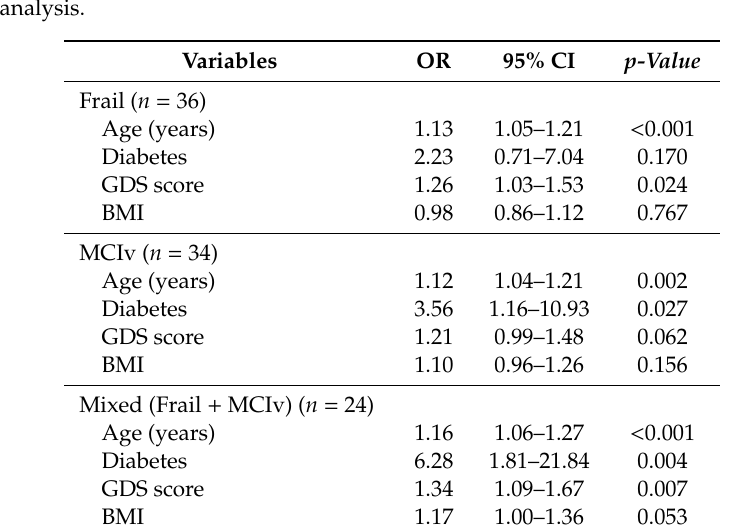
R: right-middle cerebral artery, L: left-middle cerebral artery, CVR: cerebrovascular reactivity, PI: pulsatility index, MVF: mean blood flow velocity. Analysis was performed with a Kruskal–Wallis or chi-square test. A healthy vs frail;